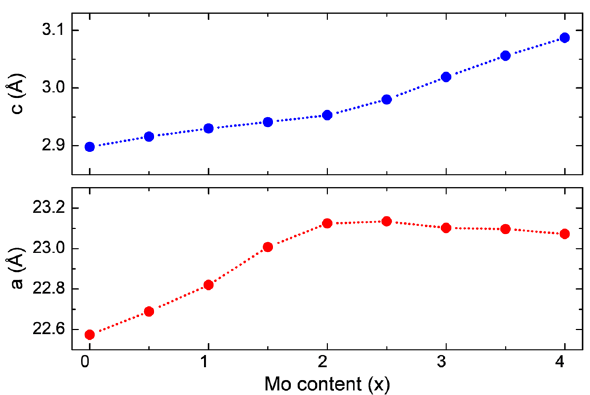
Figure 2. Cell parameters of the Mo x V 4-x AlC 3 MAX alloy as a function of the Mo content. The upper and lower panels are for cell parameters a and c, respectively.